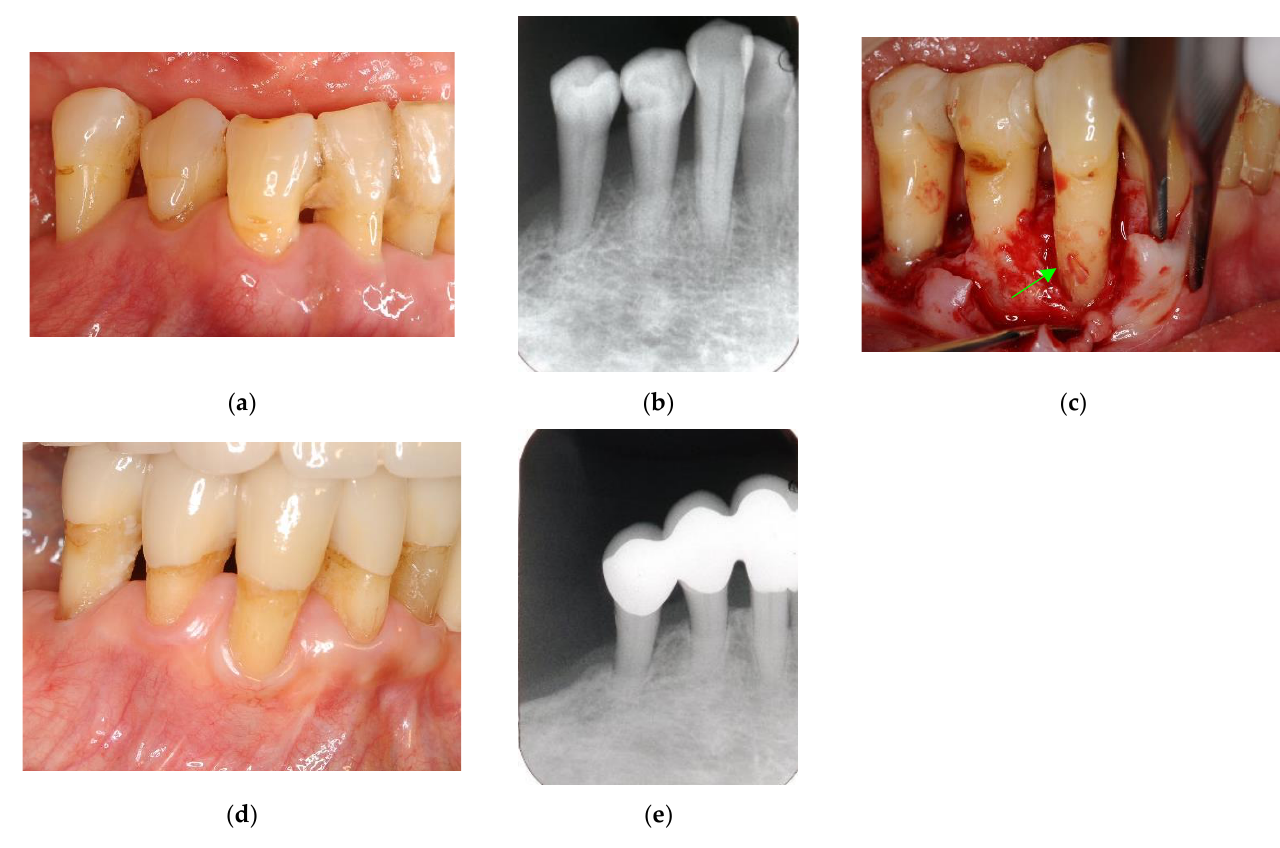
Figure 4. Clinical case 3. Female, age 73 yrs. ( a ) Intraoral view of the lower right canine at baseline, presenting gingival swelling and pus discharge at the mesial pocket. ( b ) Preoperative periapical radiograph showing that the “bone” defect was due to advanced periodontitis. ( c ) Flap retraction and debriding of the defect, presenting the piece of cementum (arrow). Periodontal regenerative treatment with enamel matrix derivative was performed. ( d ) Fixed prosthesis inserted 5 years later, with healthy gingiva (PD < 2 mm). ( e ) Follow-up periapical radiograph.